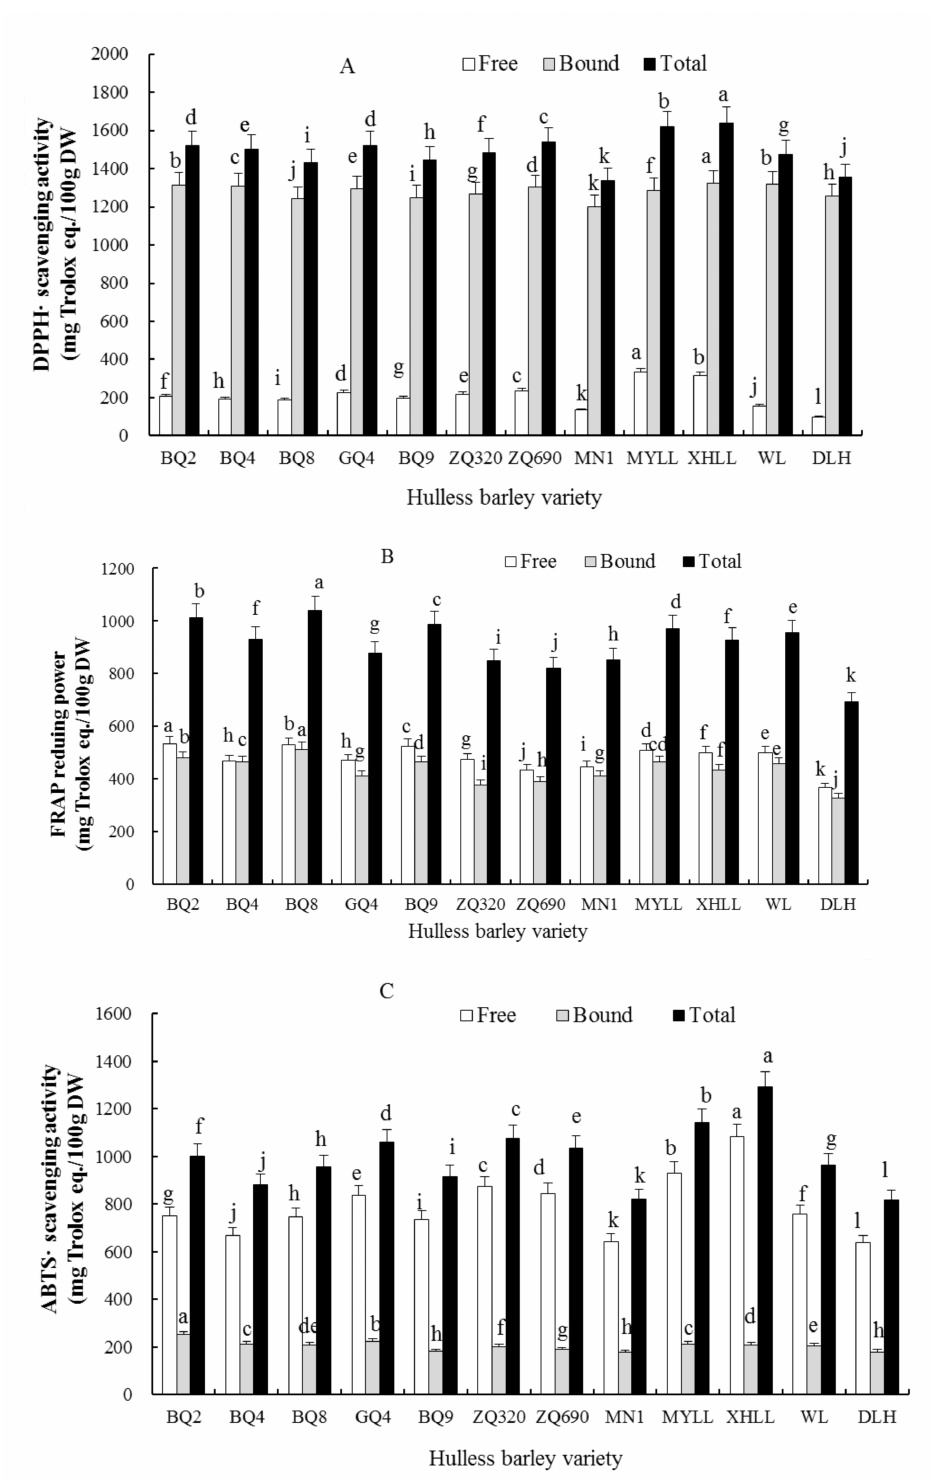
Figure 2. Analysis of the antioxidant activity of different varieties of blue highland barley. ( A ) DPPH radical scavenging activity ( B ) FRAP reduing power ( C ) ABTS • + scavenging activity. Different letters denote significant difference at the level p < 0.05. BQ2, Beiqing 2; BQ4, Beiqing 4; BQ8, Beiqing 8; GQ4, Ganqing 4; BQ9, Beiqing 9; ZQ320, Zangqing 320; ZQ690, Zangqing 690; MN1, Mennong 1; MYLL, Menyuanlianglan; XHLL, Xunhualianglan; WL, Walan; DLH,